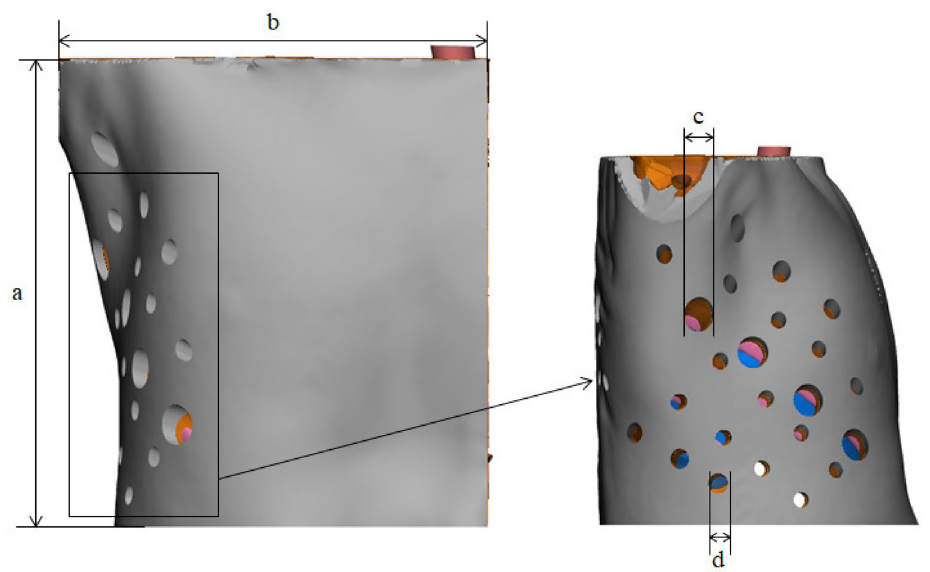
Figure 3. STL file with four landmarks specified for evaluating measurement error: ( a ) height, ( b ) width, ( c ) diameter of the VATS hole, and ( d ) diameter of another VATS hole. (3 matic 12.0,Materialise NV, Leuven,